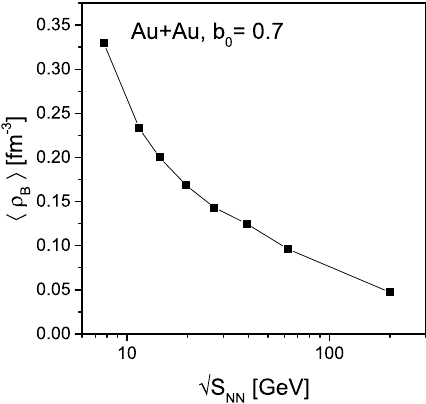
Fig. 2 Theaveragedbaryondensityatfreeze-outforAu+Aucollisions with different collision energy